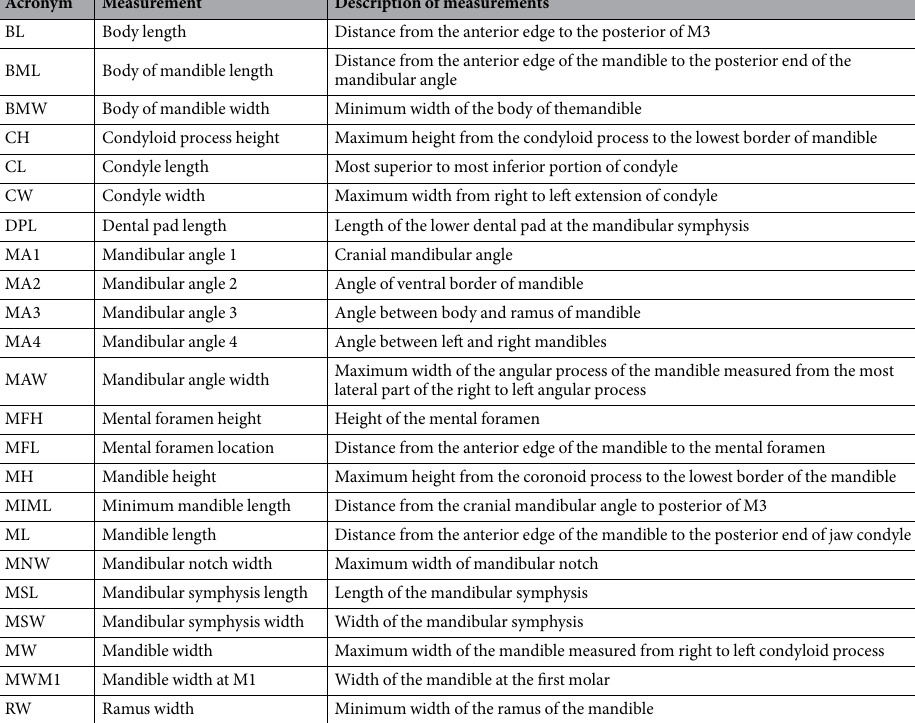
Table 2. Description of measurements taken from the dugong mandible (see Fig.